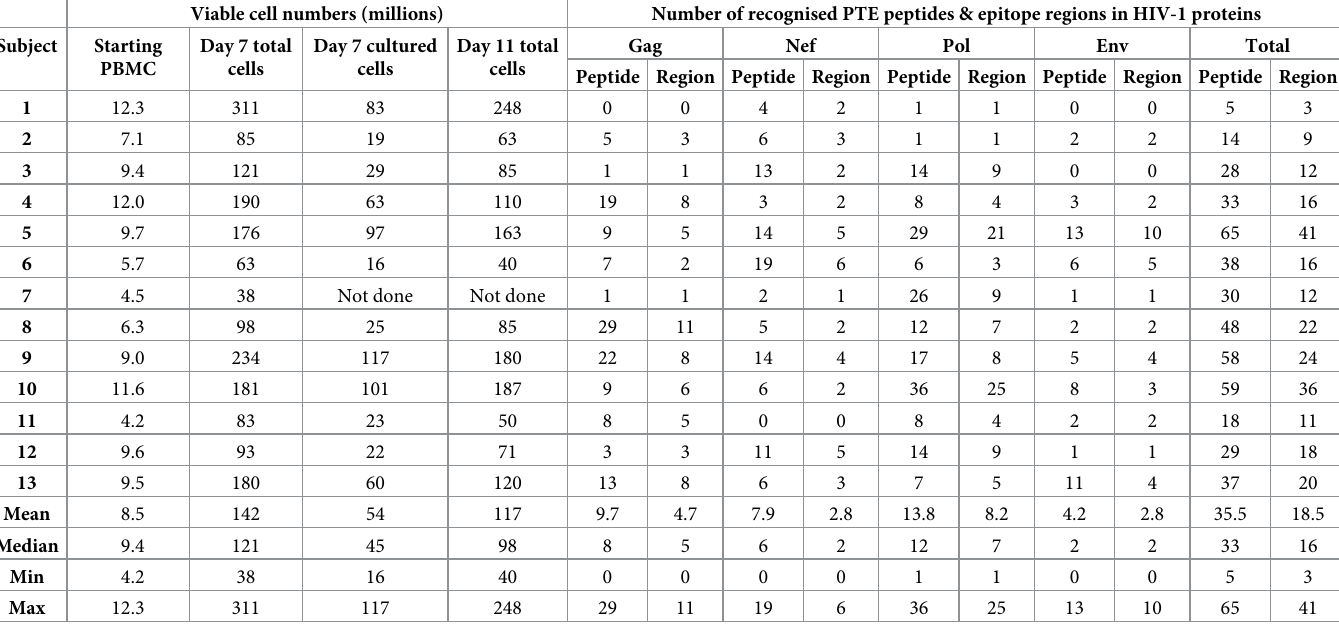
Table 4. CD8 T-cell expansion and number of PTE peptides and epitope regions recognised. Viable cell numbers